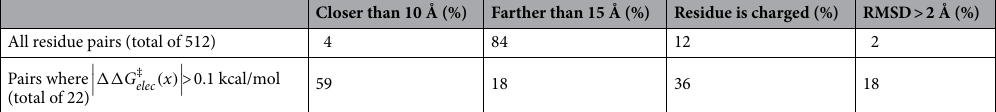
�� G ‡ elec ( x ) (cid:31) > 0.1 kcal/mol (total of (cid:31) (cid:31) (cid:31) (cid:31)